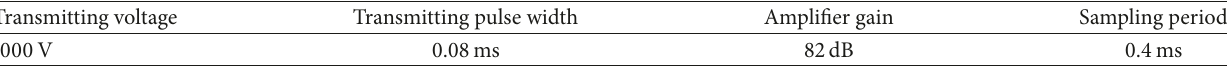
Table 3: Specific parameters of ultrasonic inspection